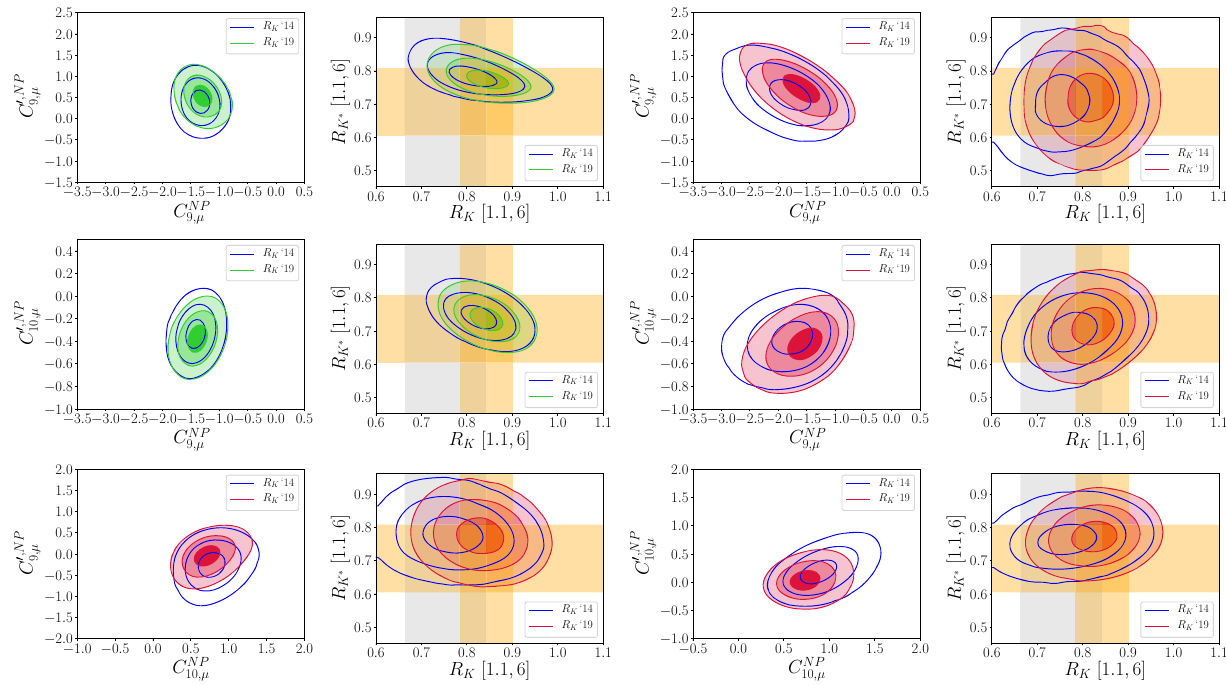
, C (cid:4) , NP ) , C (cid:4) , NP ) . Third row: analogous to the first row, ative to the WCs ( C NP 9 ,μ 10 ,μ 9 ,μ 9 ,μ but in the PDD approach only and relative to the WCs ( C NP , C (cid:4) , NP and ( C NP 10 ,μ 10 ,μ